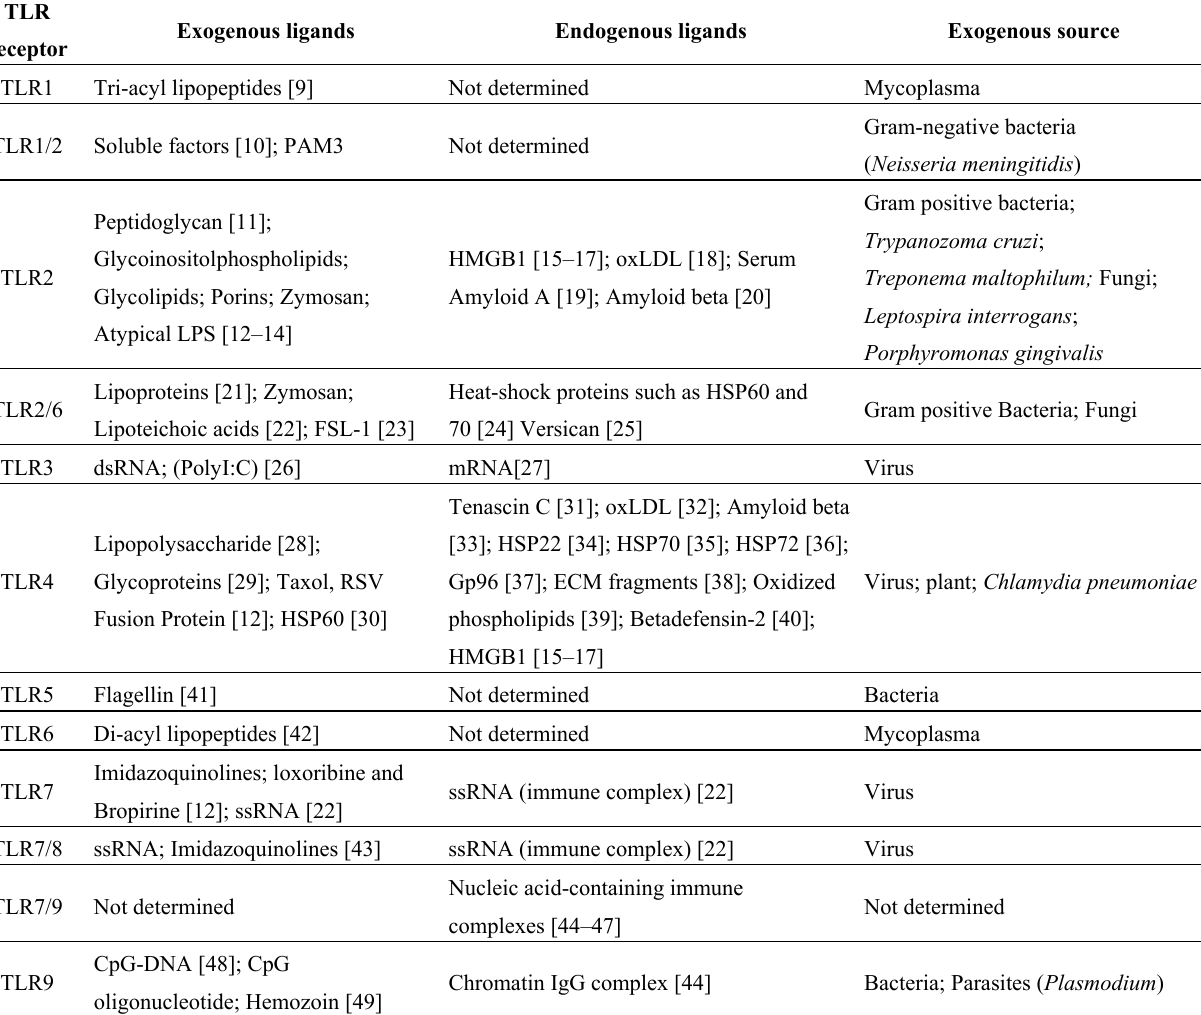
Table 1. TLRs with respective exogenous and endogenous